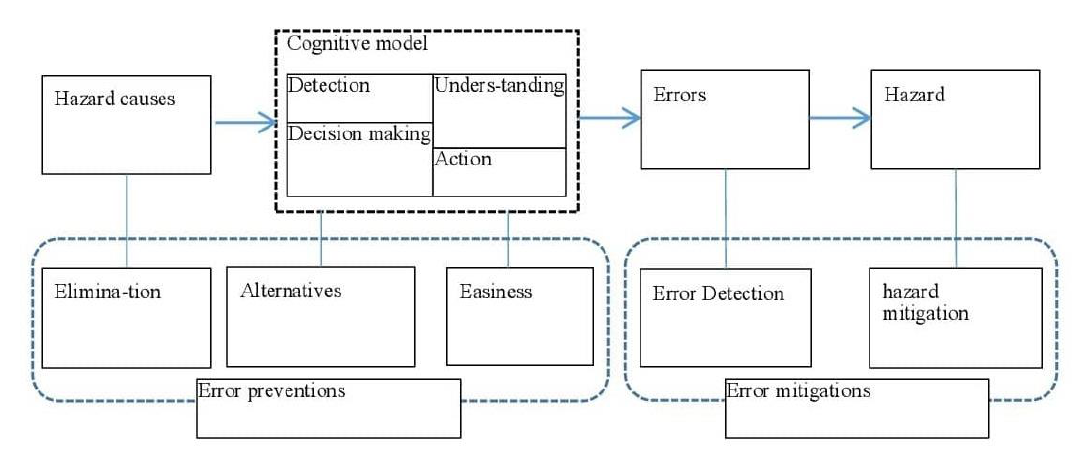
Figure 4 . Error prevention